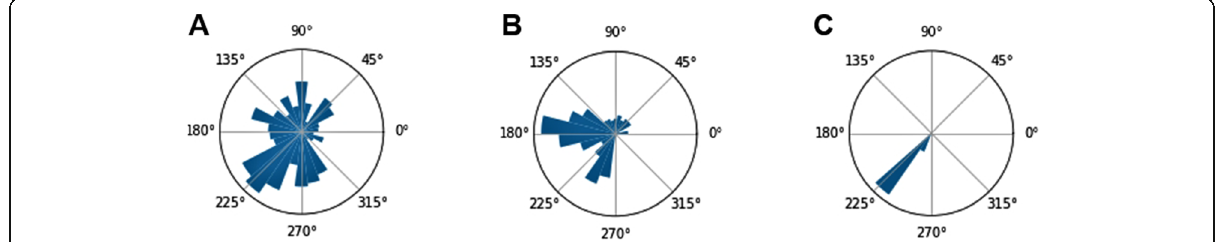
Fig. 4 Pacing Impact on the Slow Wave. Slow wave spatial histogram ( A ) prior to pacing, B during pacing before entrainment period, and C during pacing and during entrainment period, demonstrate the effect of gastric pacing on motor activity over time. Swine stomach under anesthesia is thus shown to convert from dysregulation to uniform activity once pacing induced motor entrainment